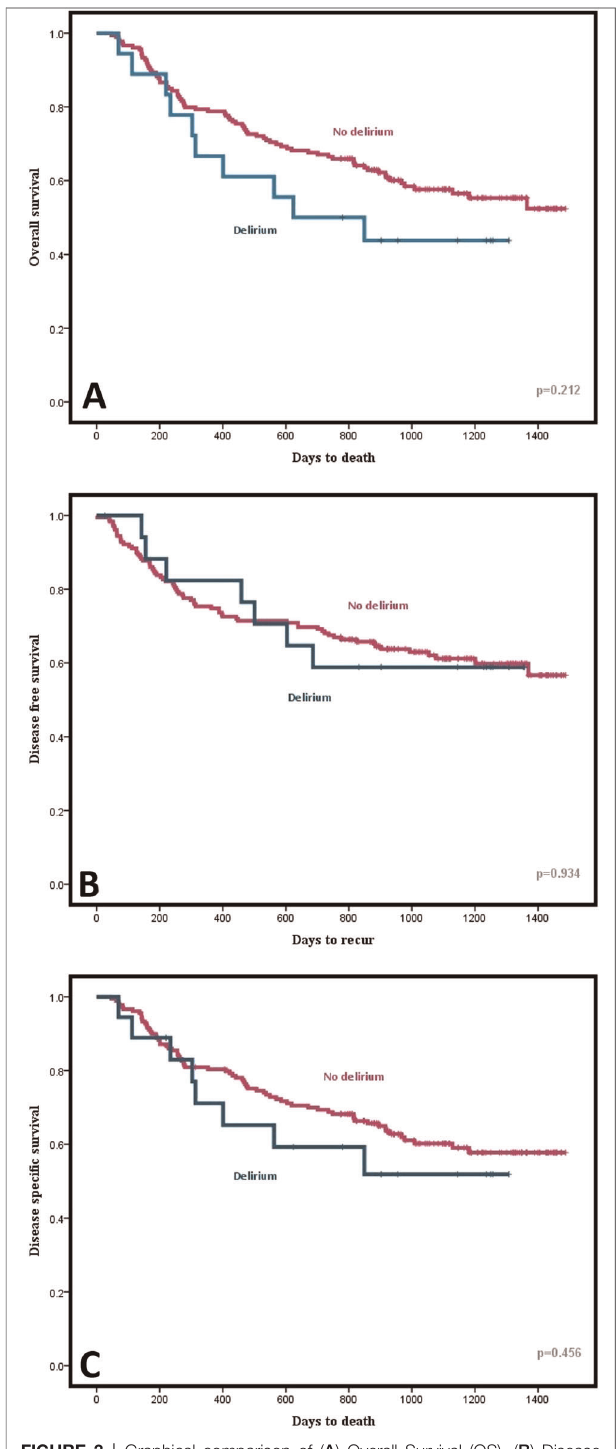
FIGURE 3 | Graphical comparison of ( A ) Overall Survival (OS), ( B ) Disease Free Survival (DFS), and ( C ) Disease Speci fi c Survival (DSS) between delirium and non-delirium groups using Kaplan-Meier